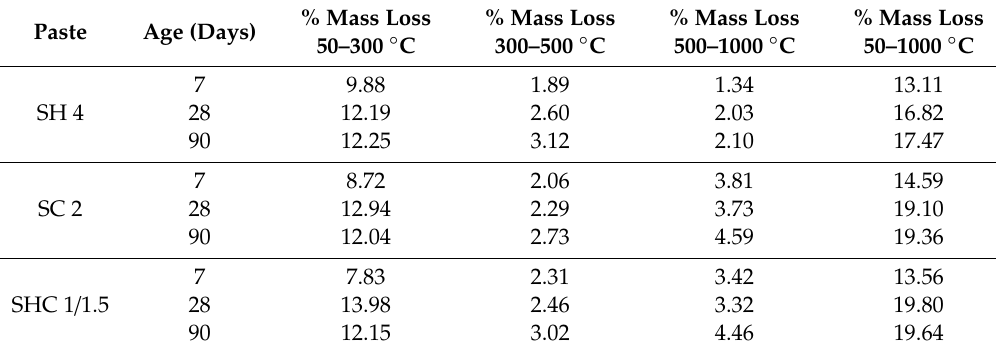
Table 3. Mass loss as a percentage for the thermogravimetry (TG) curves for the pastes cured for 7, 28 and 90 curing